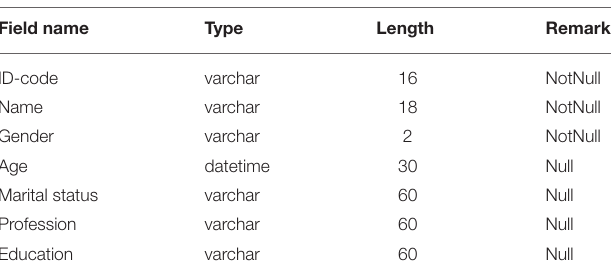
TABLE 2 | Personal information.